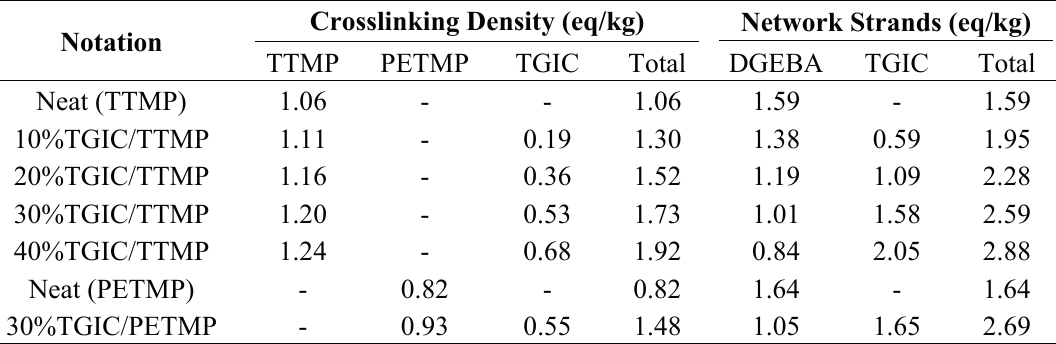
Table 3. Crosslinking density of the different cured materials calculated according to the formulation